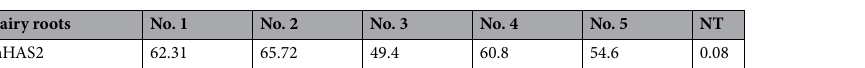
Table 1. The rhHAS2 concentration in transgenic hairy roots . Different levels of rhHAS2 were measured in all transgenic hairy root lines. Quantities are in ng/kg (wet weight). NT non-transgenic.